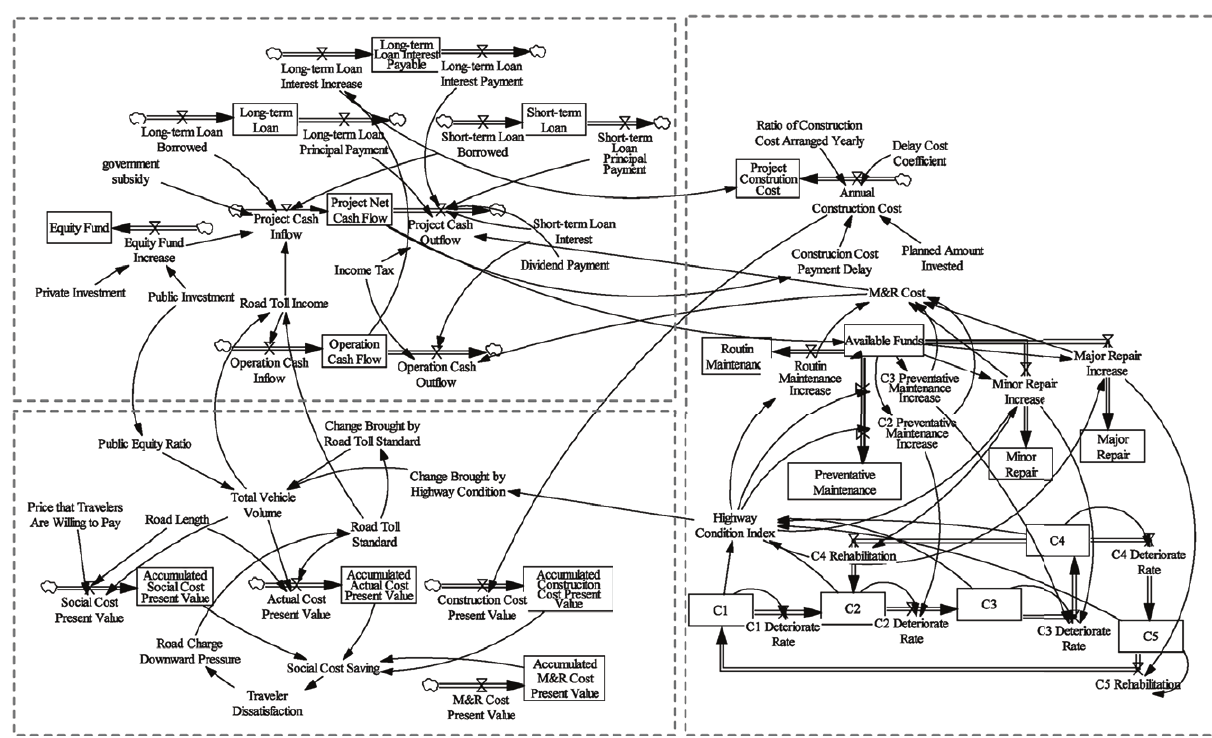
Figure 5. System dynamics model of fi nancing